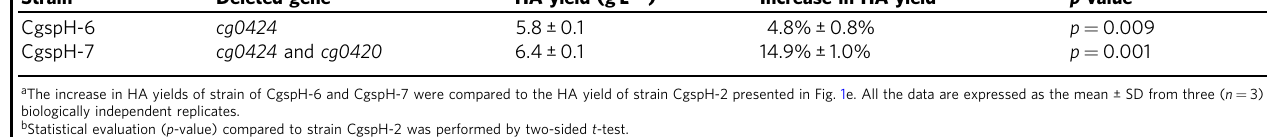
Table 1 Increase HA productivity by gene deletion of cg0424 and cg0420 .